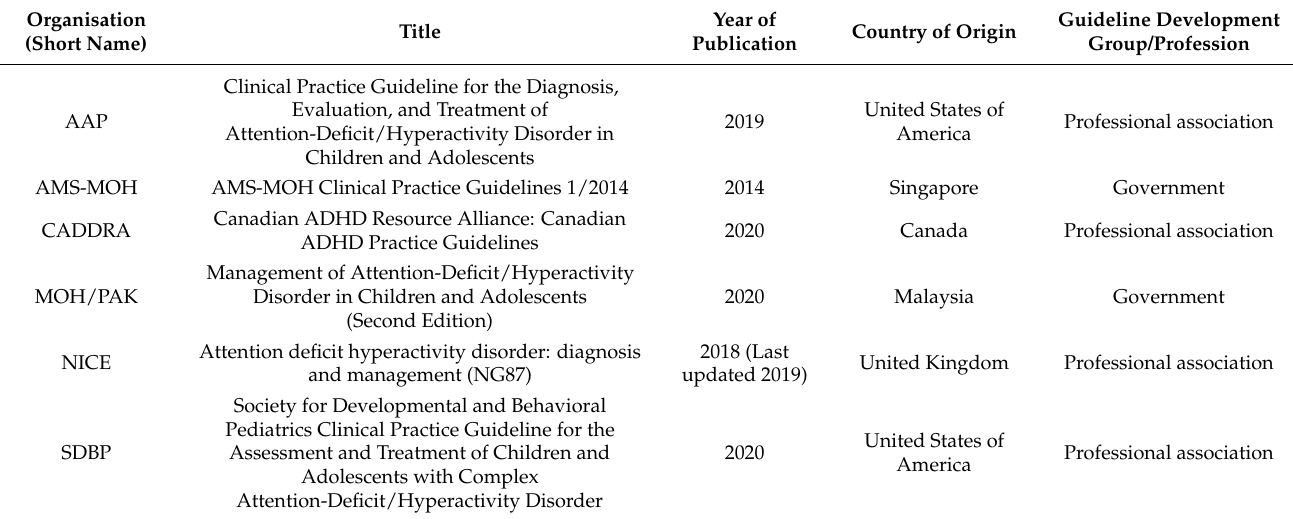
Table 2. General characteristics of ADHD clinical practice guidelines.